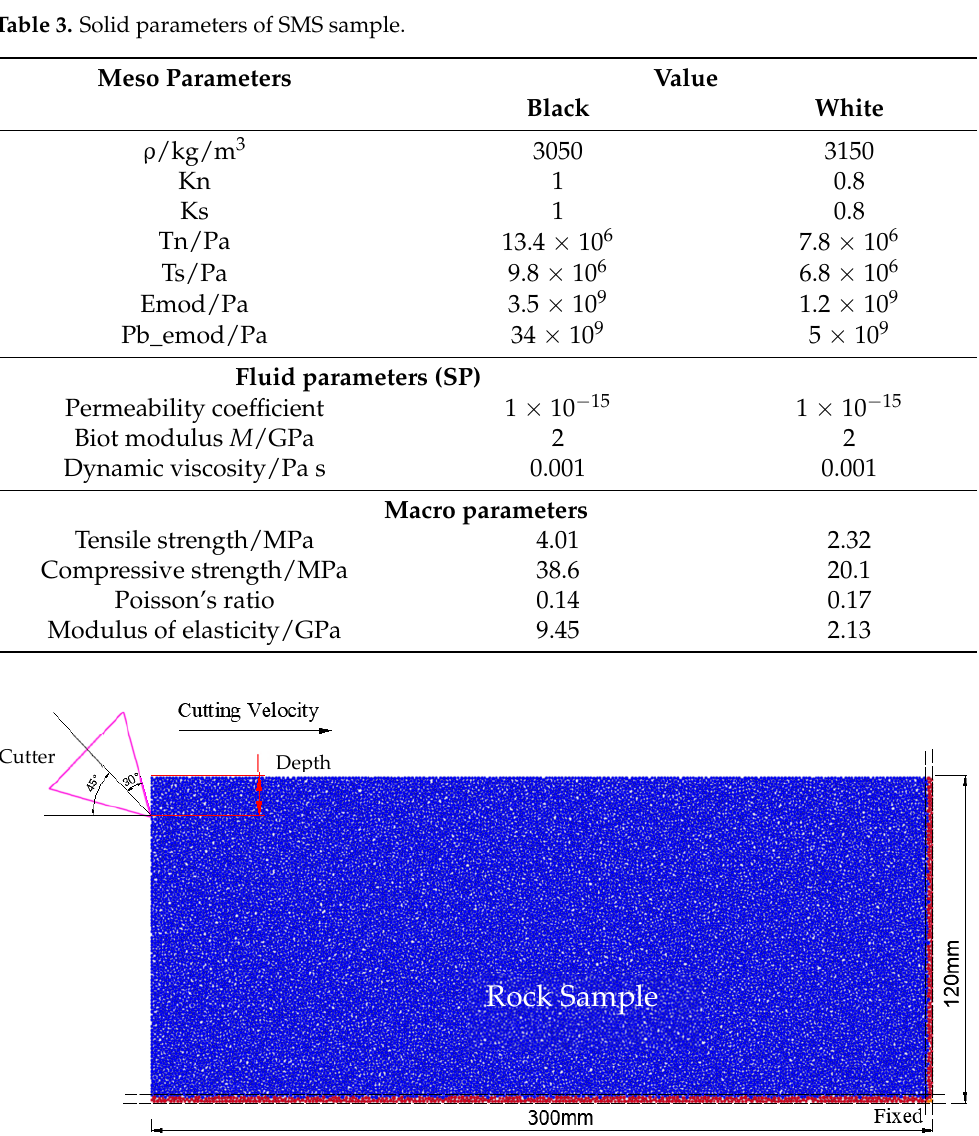
10 of 19 Table 3. Solid parameters of SMS sample. Meso Parameters